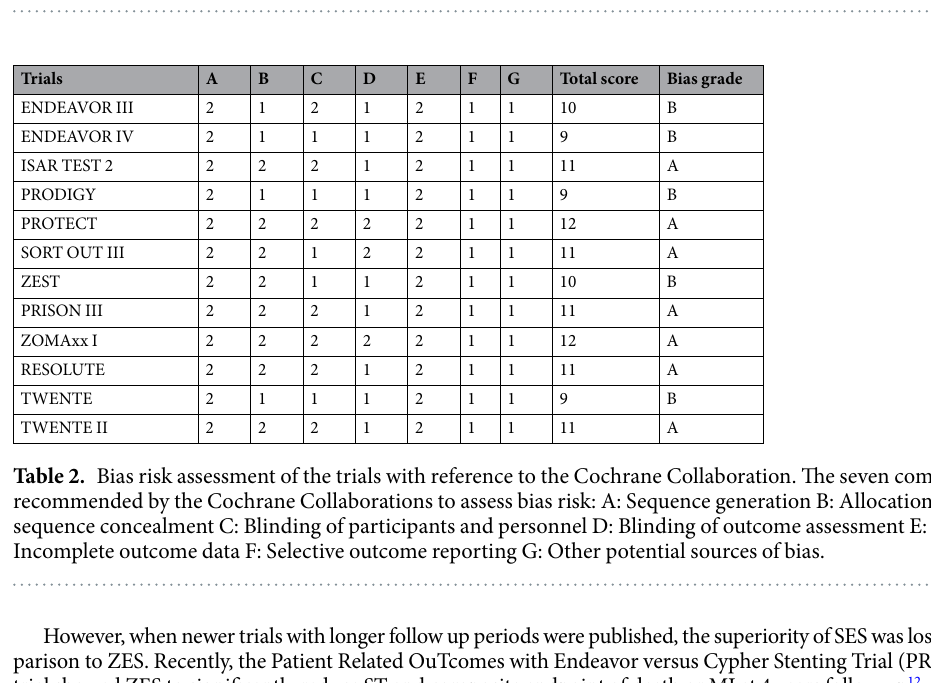
Figure 2. Long term Stent Thrombosis which was associated with ZES versus SES or